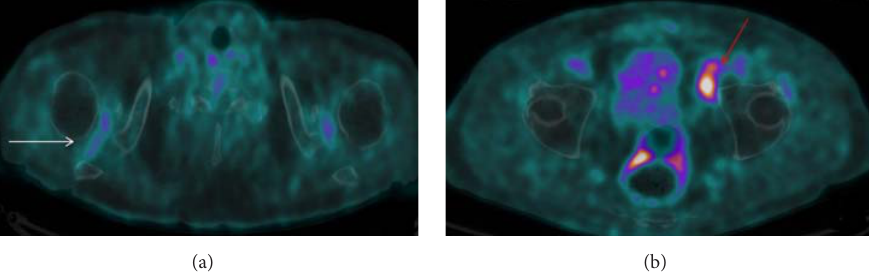
Figure 1: PET-CT pictures of symmetrical shoulders hypermetabolic bursitis (a) and of metabolic active iliac lymphadenopathy (b).